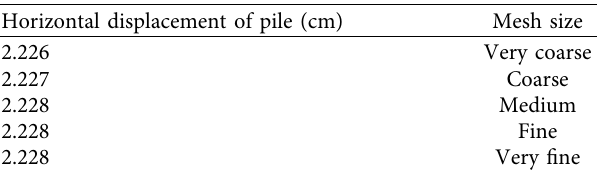
Table 3: Effect of change in mesh size on the horizontal dis- placement of